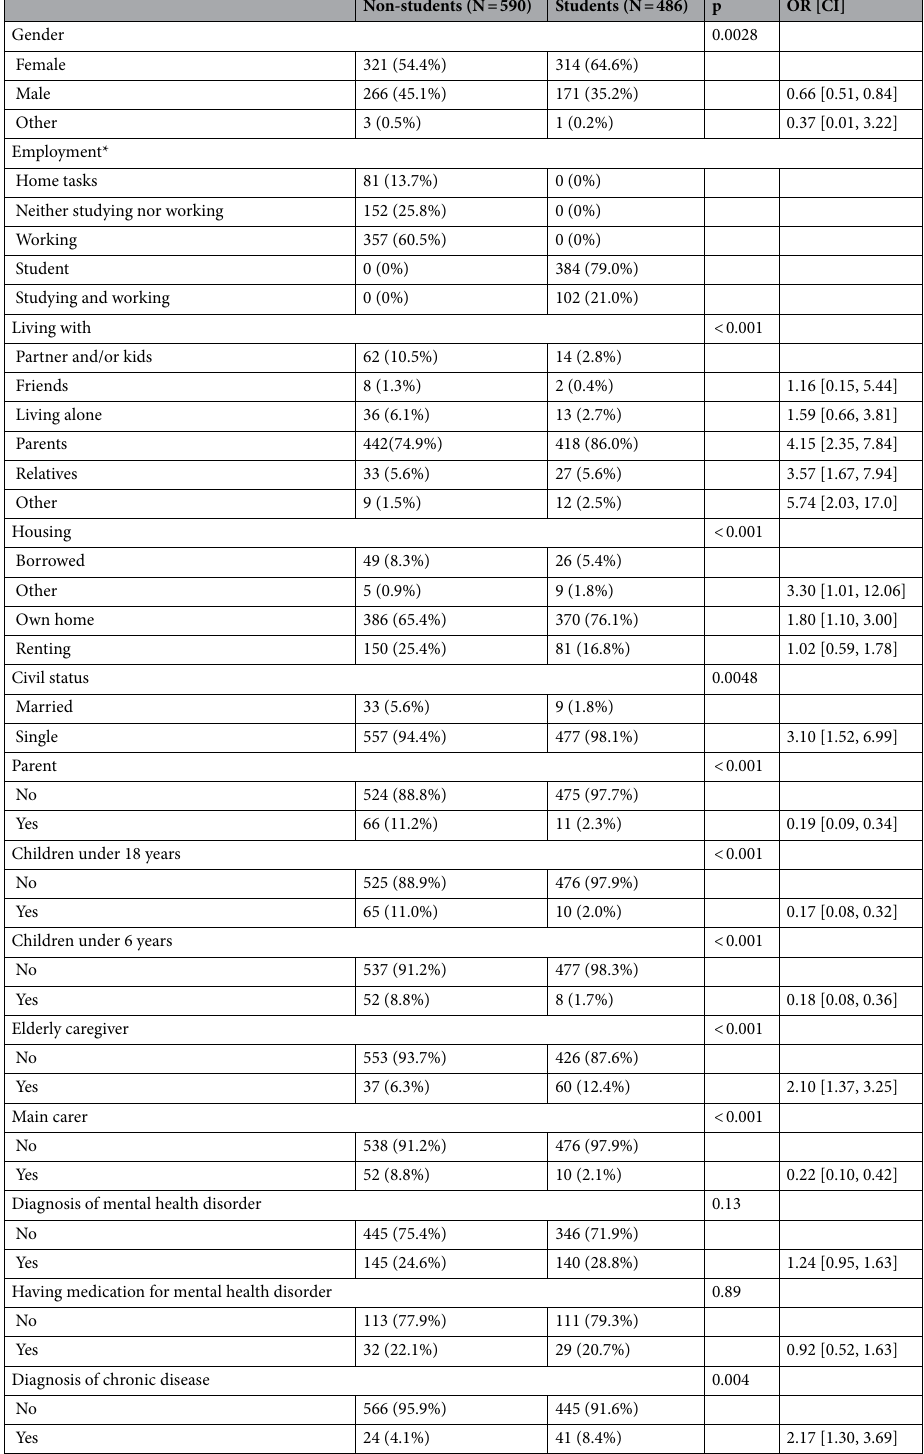
Table 3. Descriptive statistics, p values and effect sizes of the categorial predictors by group. * Dependence test between employment and group was not conducted due to being part of the non-student group exclude the possibility to be studying and to be studying and working. However, we present the description of the categories for informative